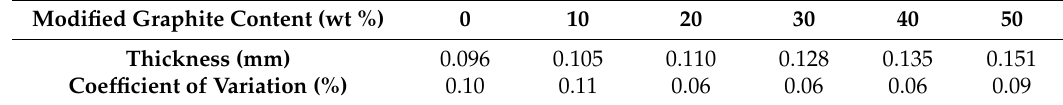
Table 2. The thickness of the modified-graphite/PU composite